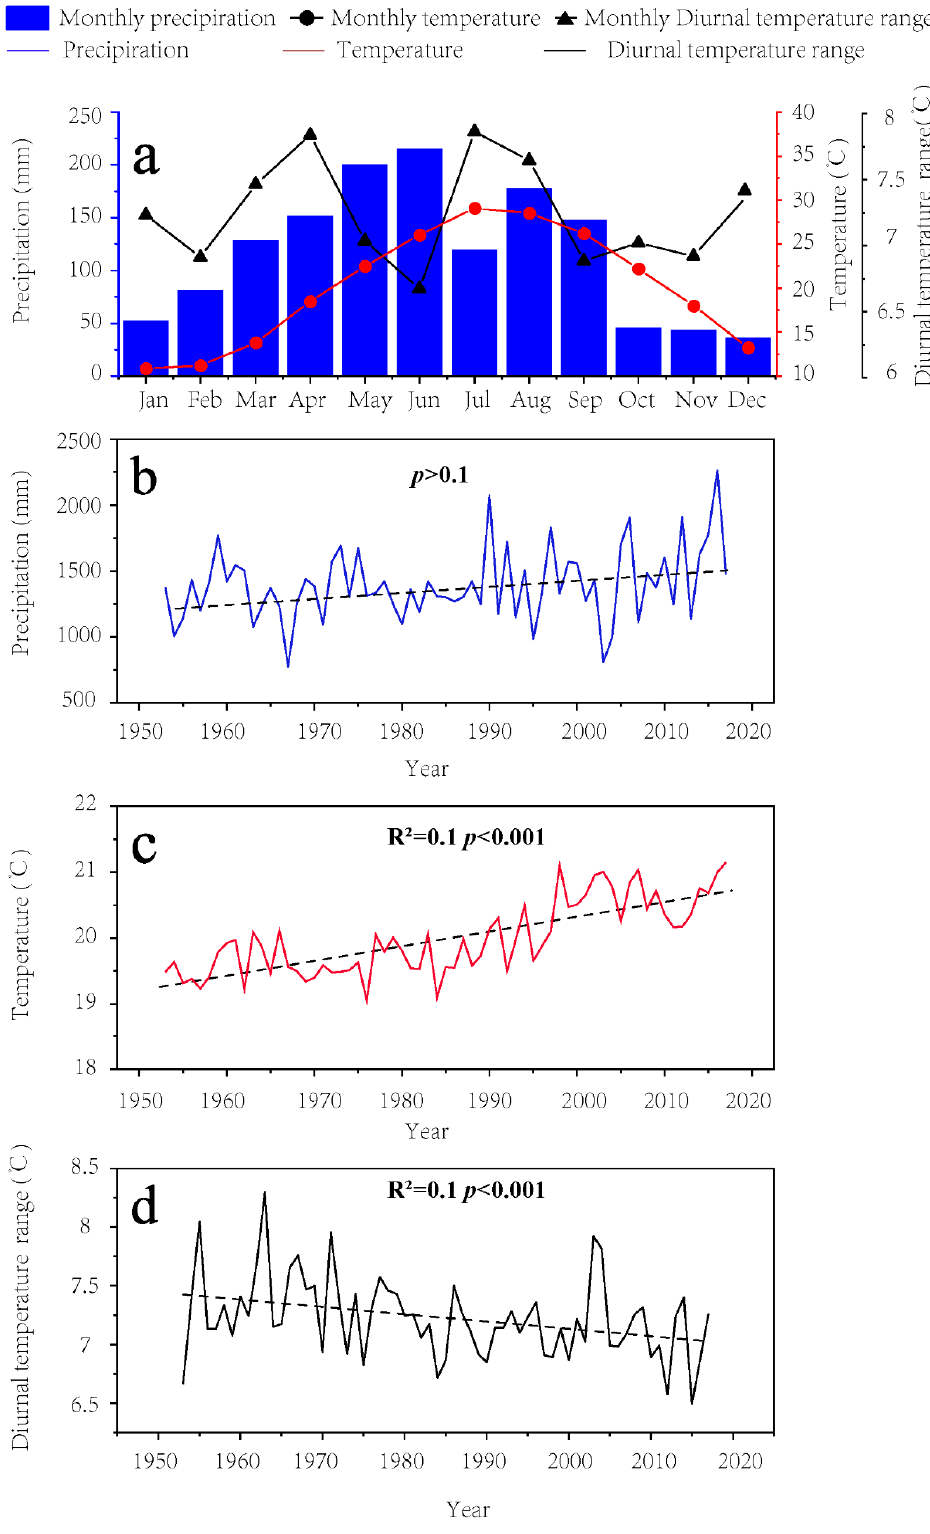
Figure 2. ( a ) Monthly climatic diagram at the Fuzhou meteorological station near the sampling site for the period of 1953–2017. Time series of the ( b ) precipitation, ( c ) mean temperature and ( d ) diurnal temperature range for the period of 1953–2017.